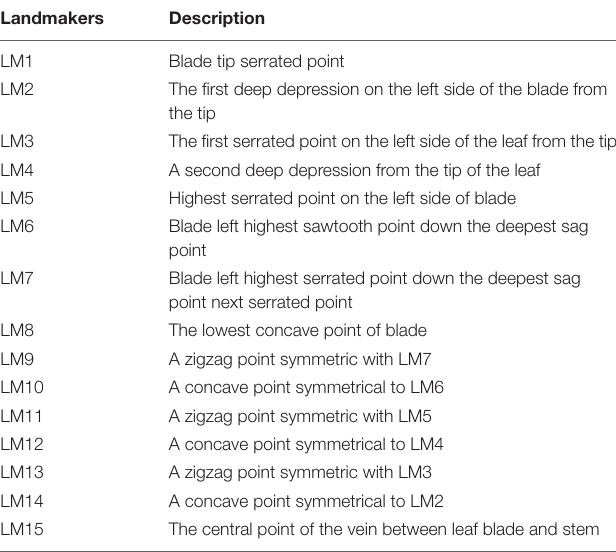
TABLE 1 | Description of the landmarks of Asteropyrum leaves.